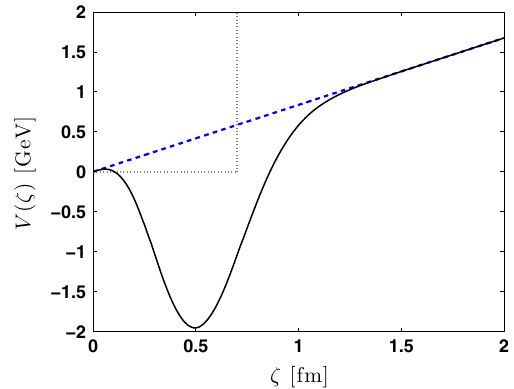
Fig. 1 The confining soft-wall linear potential V (ζ) = α 2 ζ ( α = 0 . 41GeV) as function of ζ (fm) ( dashed line ), is compared with the IR-improved potential introduced in Refs. [40,41] (see Eq. (11) and Sect. 2.2 for comments). Also a hard-wall potential at ζ 0 ∼ 1 /(cid:15) QCD is sketched ( dotted line )